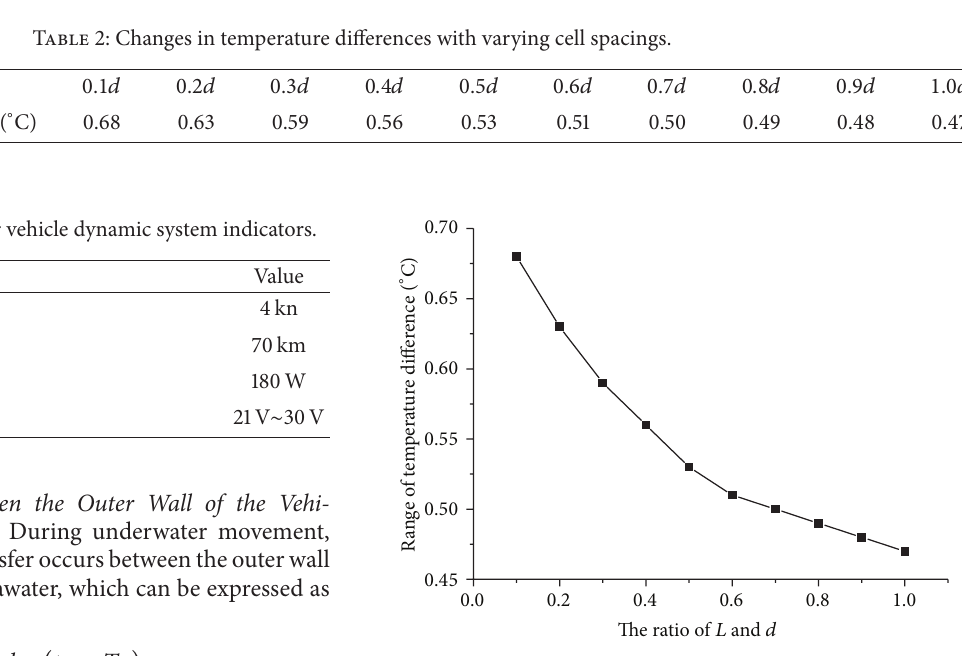
Figure 3: Curve of the temperature difference variations with the distance between the